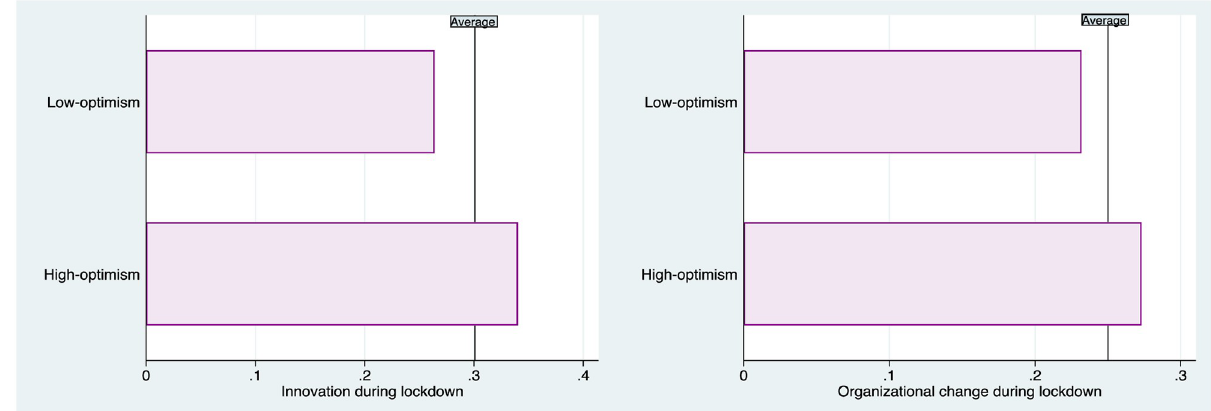
Fig 3. Entrepreneurial actions during Covid-19 –by optimism level. Note: The figure on the left (right) indicates the fraction of businesses which report to have made any innovation (organizational change) during January-April 2020, separately for entrepreneurs below and above the median threshold of optimism. The vertical line denotes the average